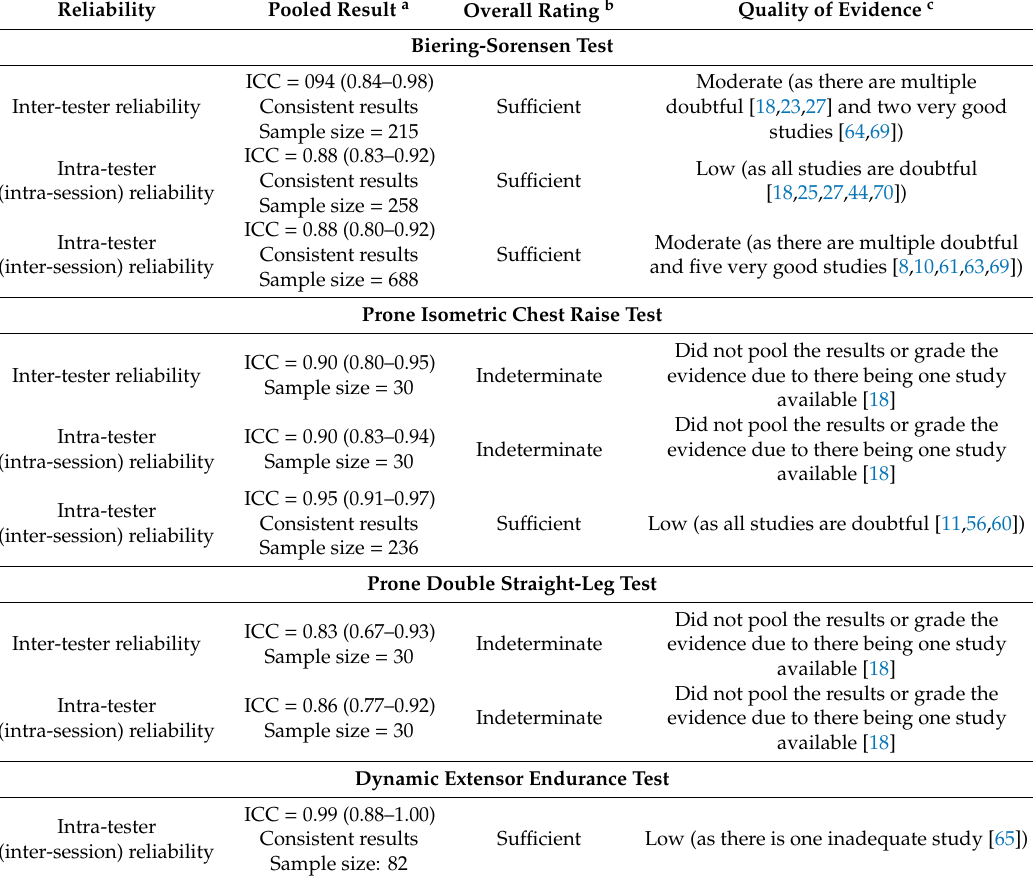
Table 1. Summary of findings